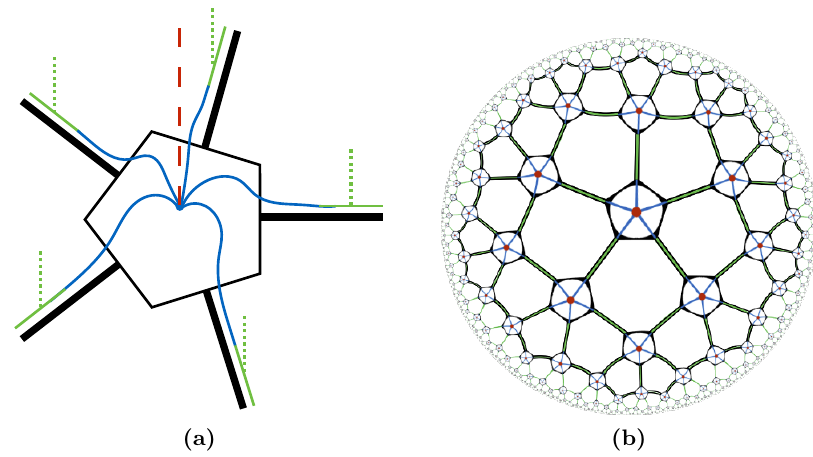
Figure 4. (a) The structure near each vertex of our edge-mode code. The thick black legs carry 5 indices. The central input (long dashes, red in color version) corresponds to a bulk matter (cid:12)eld as in [2] while the inputs on each edge (short dashes, green in color version) are to be interpreted as degrees of freedom of a bulk gauge (cid:12)eld. (b) A sketch of the full edge-mode